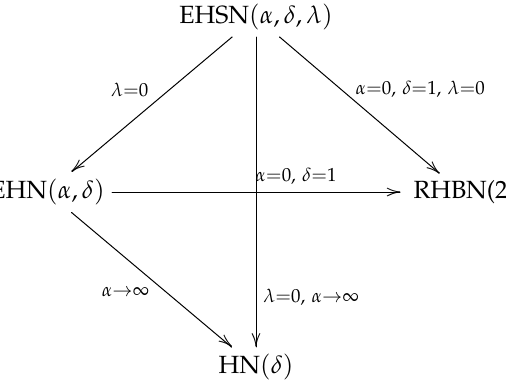
Figure 1. Particular cases for the EHSN distribution.